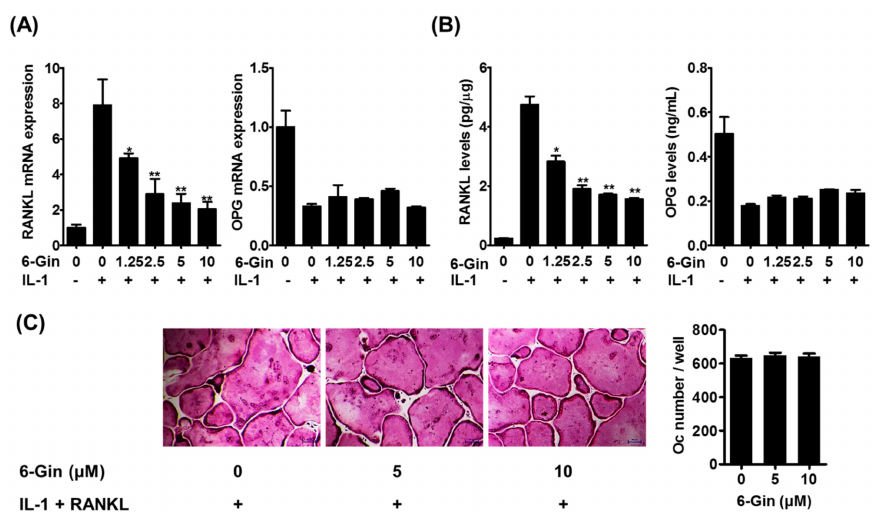
Figure 3. 6-Gingerol inhibits IL-1-induced RANKL expression in POBs. ( A ) POBs were incubated with or without IL-1 (10 ng/mL) and 6-gingerol (6-Gin, 1.25–20 µ M) for 24 h. Gene expression levels of RANKL and osteoprotegerin(OPG)wereanalyzedusingquantitativereal-timePCR;( B )RANKLlevelsinPOBlysatesand OPG levels in the culture medium were determined using corresponding enzyme-linked immunosorbent assay (ELISA) kits; ( C ) POBs and BMCs were co-cultured with or without 6-gingerol (5 or 10 µ M), and IL-1 (10 ng/mL), and RANKL (50 ng/mL) for five days. The number of osteoclasts was counted. * p < 0.05 and ** p < 0.01 vs. treatment with IL-1 alone. Scale bar = 100 µ